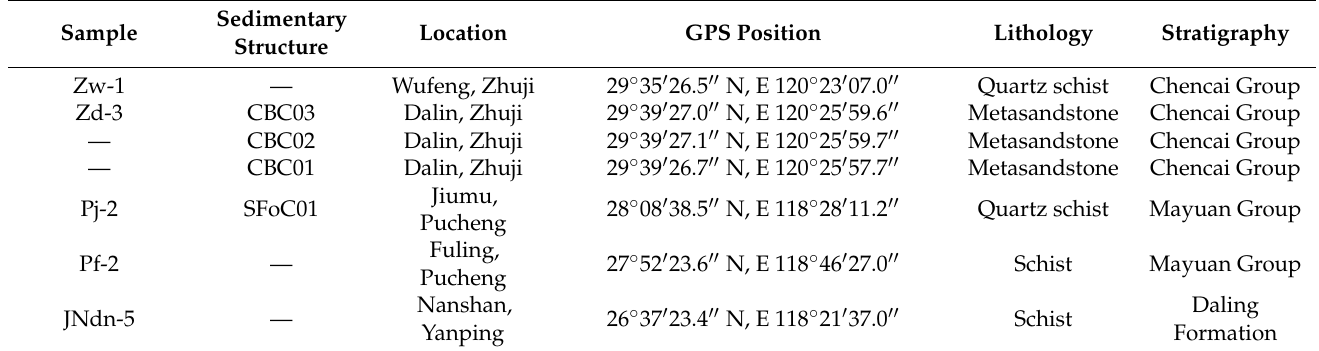
Table 1. Sample details from the Precambrian strata in the northeastern Cathaysia